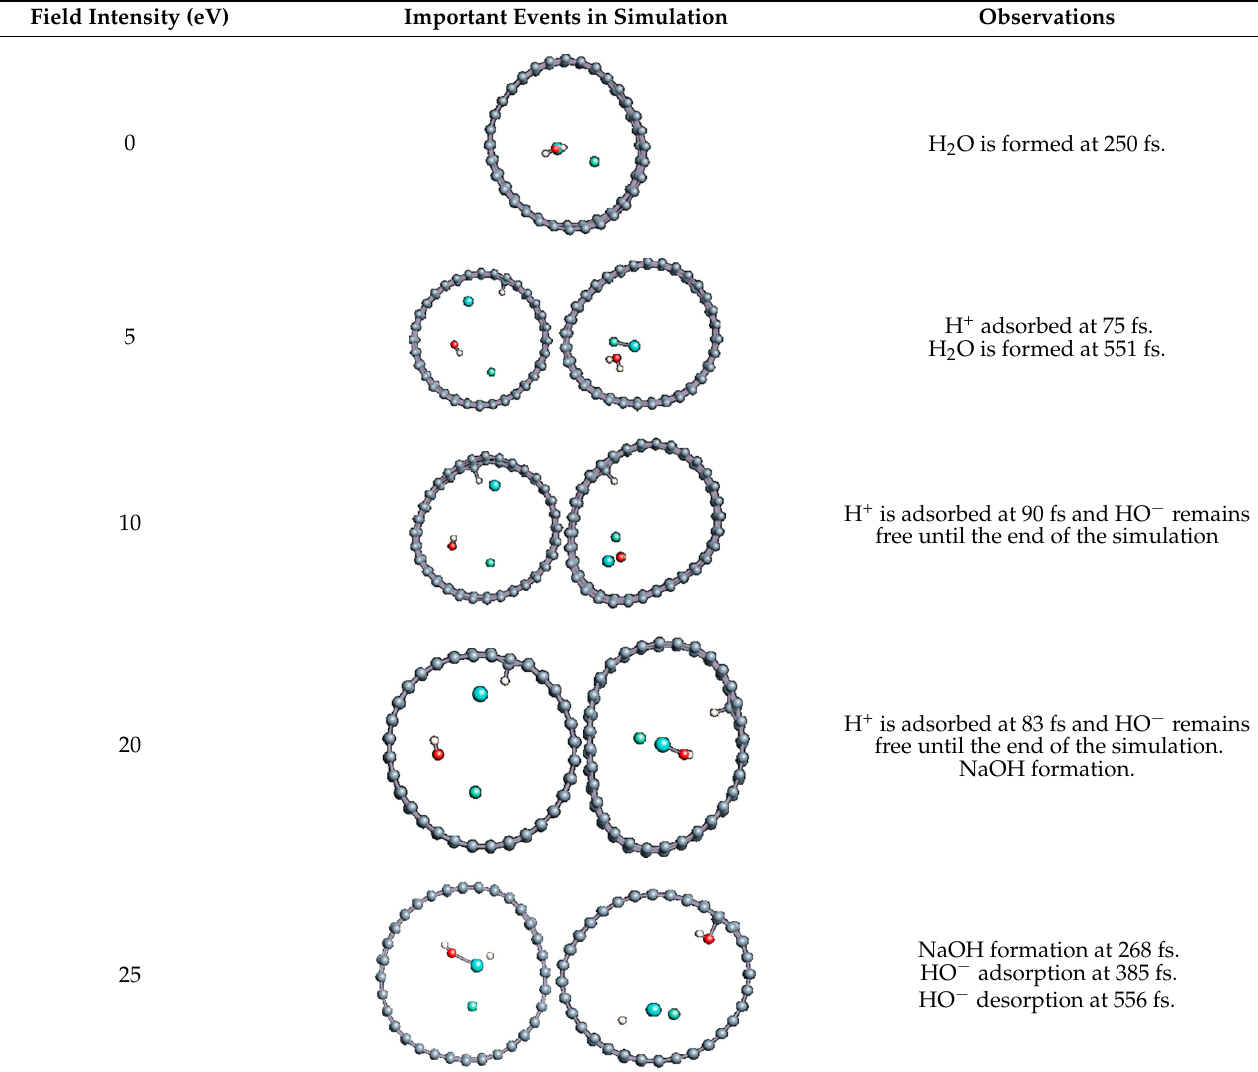
Table 7. Dissociated water molecules inside (16,0) CNT under electric bias in the presence of a salt. Field Intensity (eV)